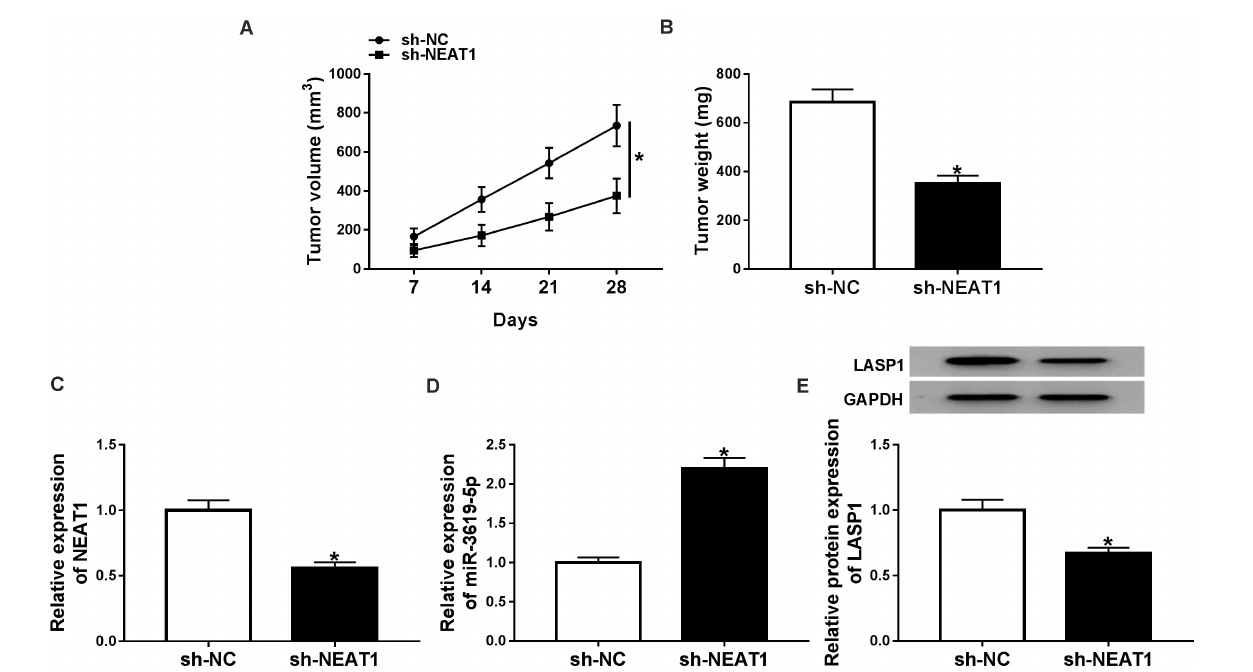
FIGURE 6 | NEAT1 knockdown inhibited RB growth in vivo . (A) Tumor volume was inhibited by NEAT1 knockdown. (B) The weight of tumors was reduced after NEAT1 silencing in vivo . (C) The interfering efficiency of sh- NEAT1 was determined by qRT-PCR. (D) QRT-PCR showed that NEAT1 knockdown up-regulated miR-3619-5p expression in vivo . (E) Western blot analysis showed that NEAT1 knockdown repressed the protein level of LASP1 in vivo . * P <